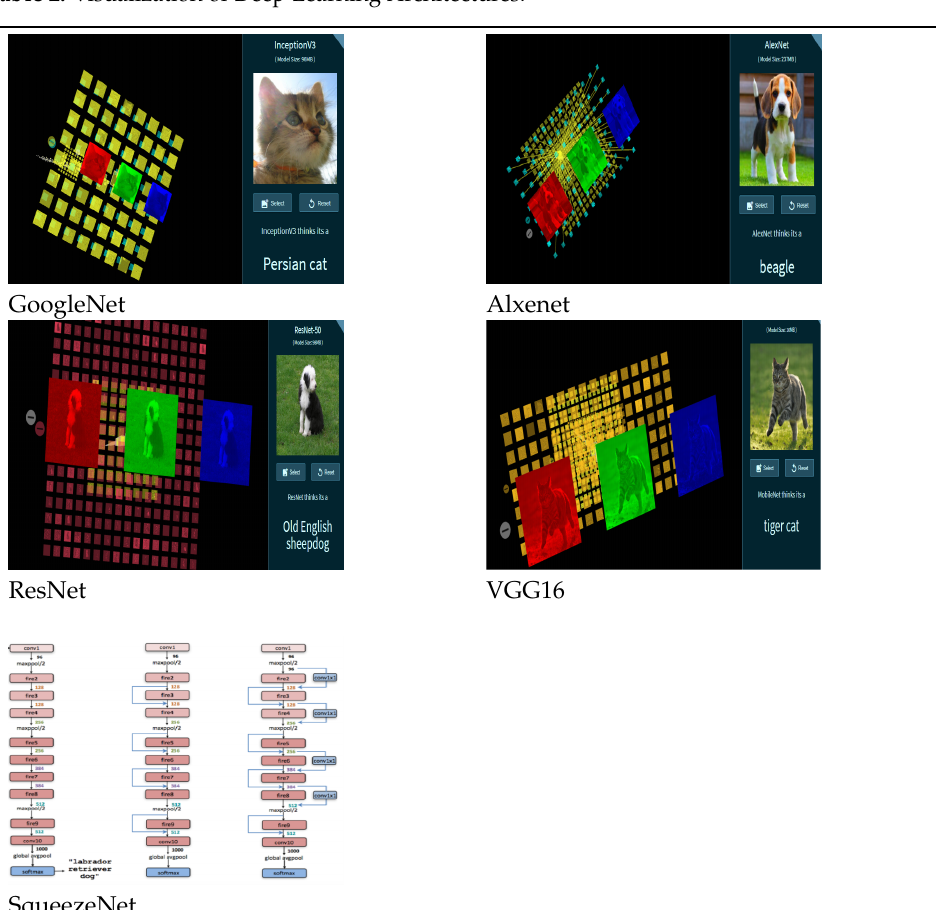
Table 2. Visualization of Deep Learning